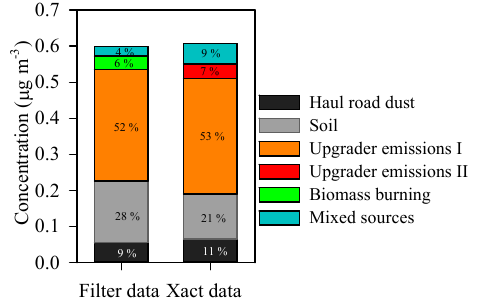
Figure 5. Average mass contributions at AMS13 of each factor de- rived from the hourly Xact and 23h integrated filter data during the intensive campaign from 13 August to 4 September